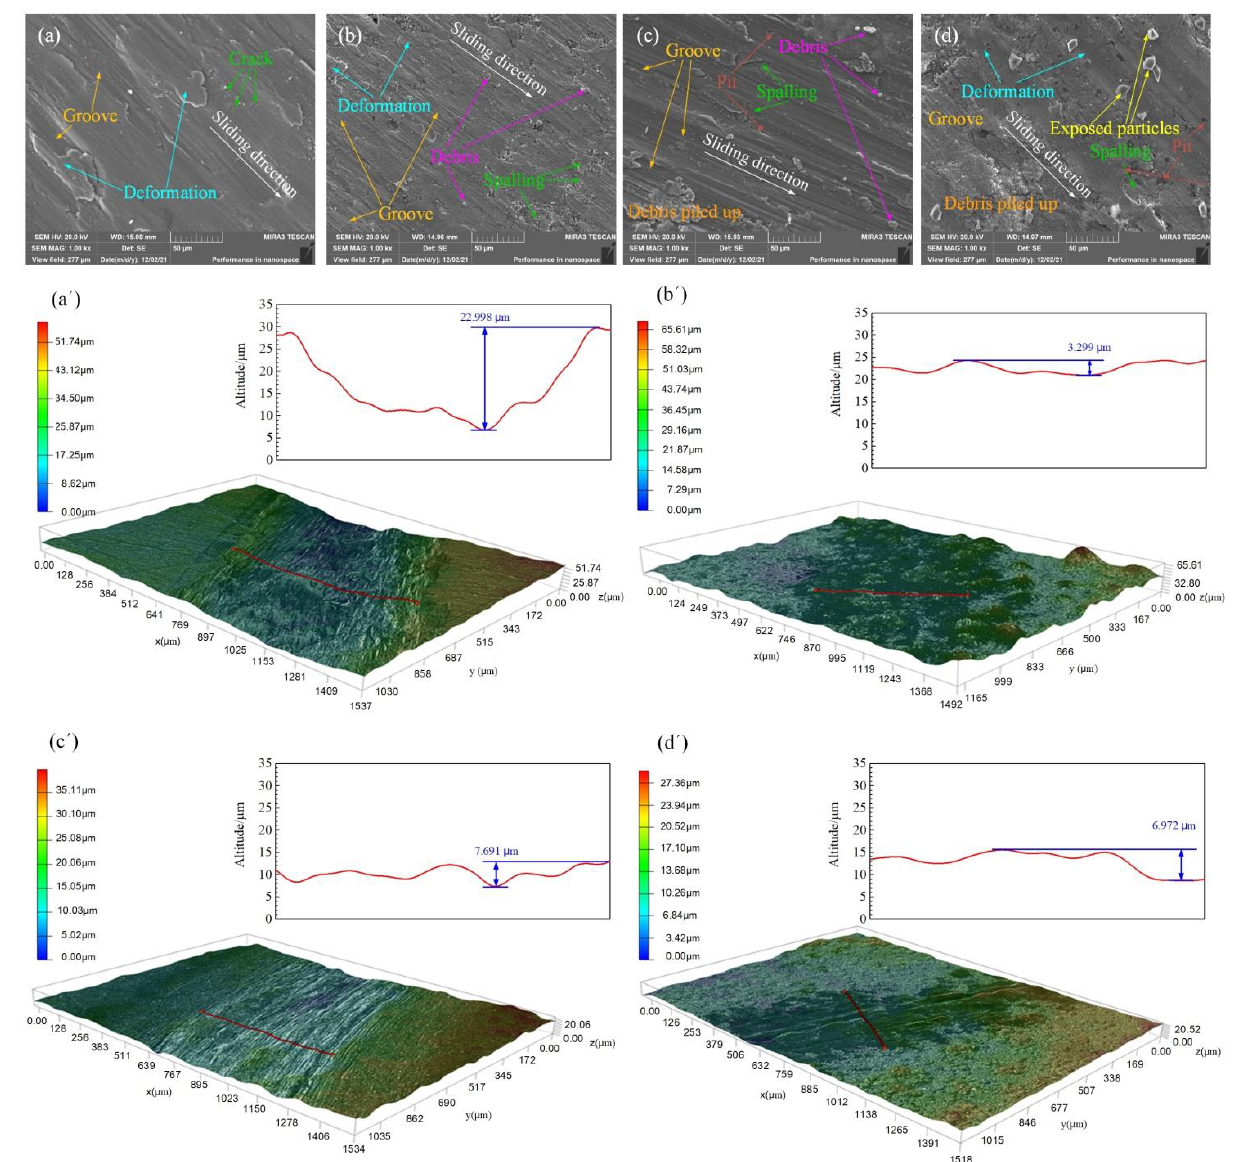
Figure 6. SEM images and 3D morphologies of the worn surface. ( a , a ’ ) S1 sample; ( b , b ’ ) S2 sample; ( c , c ’ ) S3 sample; ( d , d ’ ) S4 sample. ( c , c’ ) S3 sample; ( d , d’ ) S4